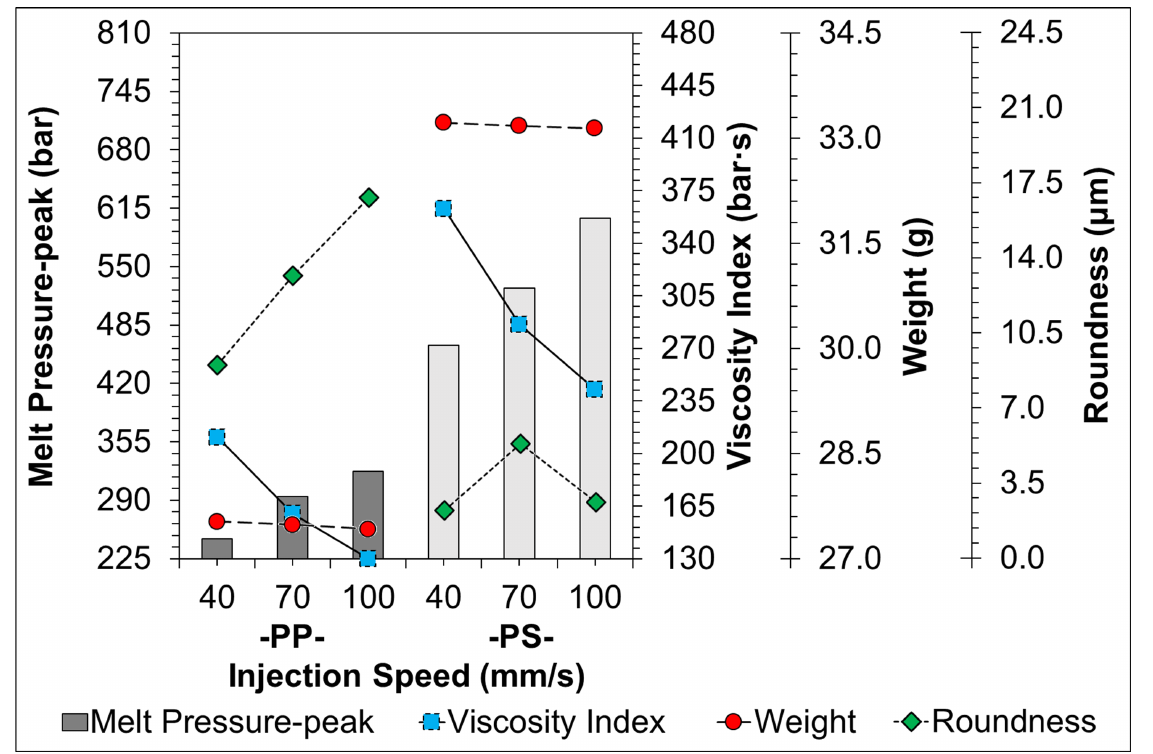
Figure 14. Trend-diagram of the effect of injection speed on melt pressure-peak (bar-graph), calculated viscosity index (continuous-line), and its sample weight (chain-line)/roundness (dotted-line).